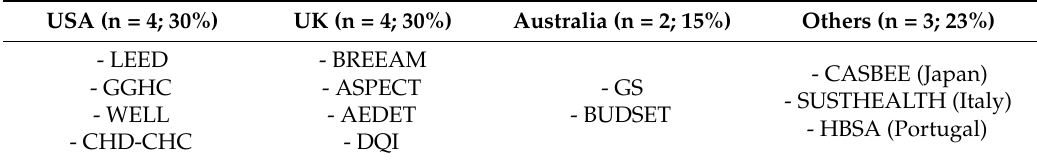
Table 3. Classification of the tools collected according to the geographic area of